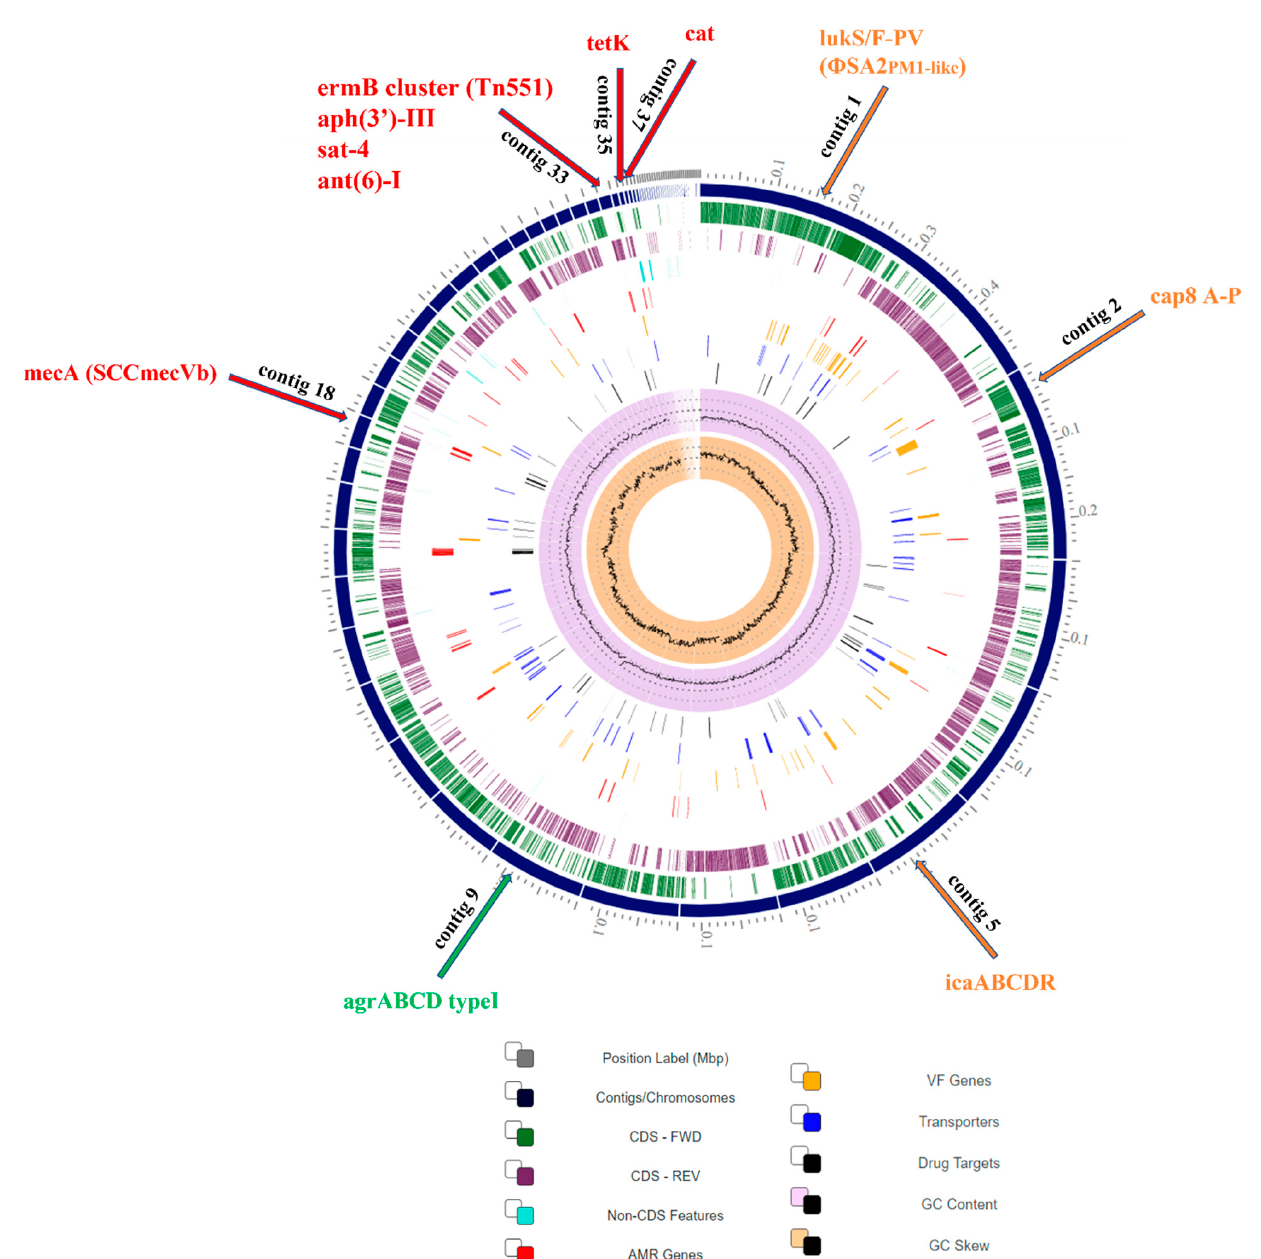
Figure 1. Circular genome view (CGV) of SO574/12 MRSA, with the essential genes’ assignment. Each type of locally collinear block (LCB) was marked with a different color. LCBs con- taining highly conserved homology regions were assigned with the same stain. Homology regions that were defined within both aligned genomes were connected with a line in the same color. Thirty-six common LCBs were detected. The maximum and minimum lengths of the LCBs were 372,796 bp and 641 bp, respectively, in the ZY05 genome, and 372,878 bp and 643 bp, respectively, in the SO574/12 genome. The summary length of the LCBs was 2,761,725 bp in the ZY05 genome and 2,750,602 bp in the SO574/12 genome, which were 97.85% and 98.50% of the total genome sizes, respectively. The erm B gene was detected in contig 33 (size 14,772 bp) of the CA-MRSA SO574/12 genome. The size of the homology region in the genome of CA-MRSA ZY05 was 14,767